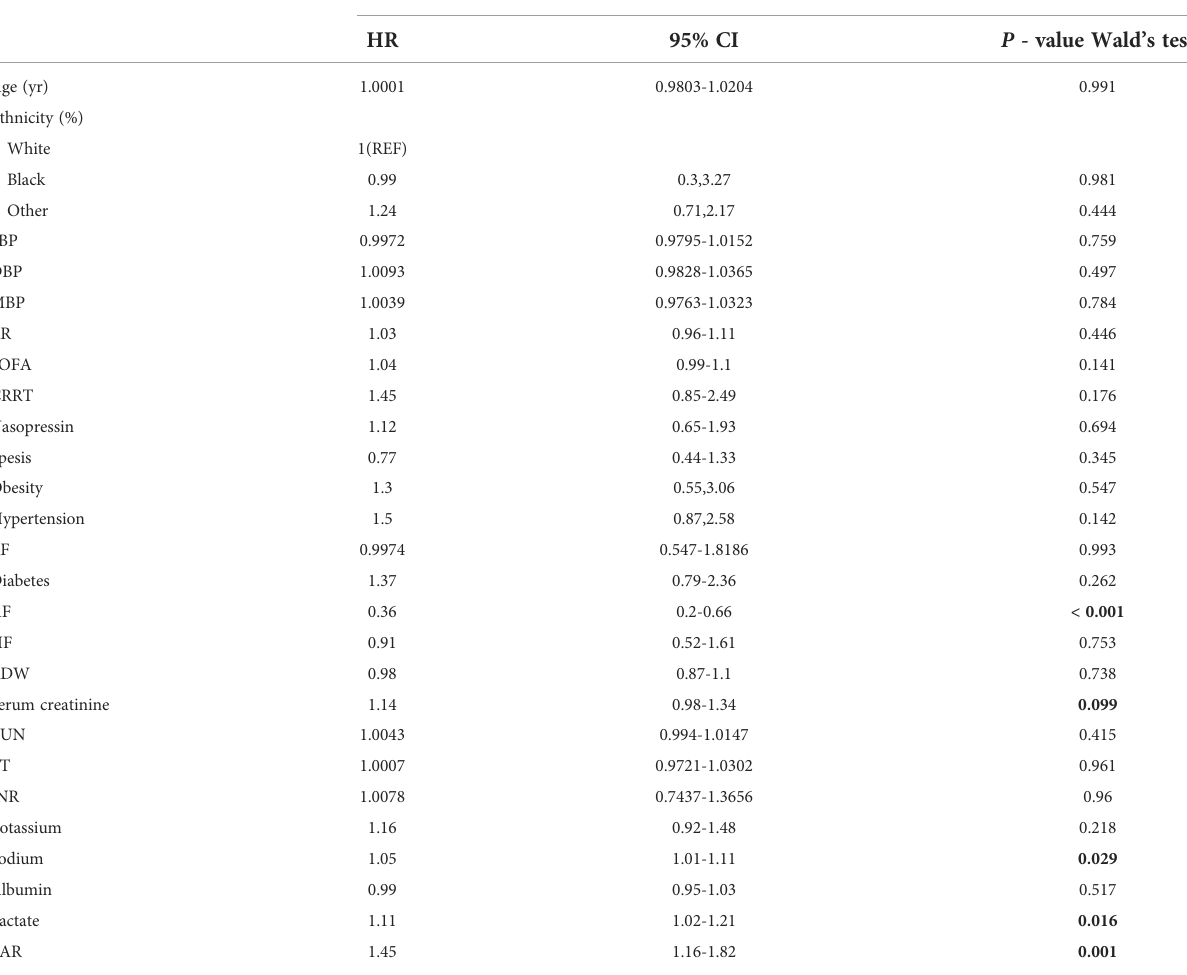
TABLE 2 Univariate COX analysis of risk factors for death within 28-d in patients by logistic regression